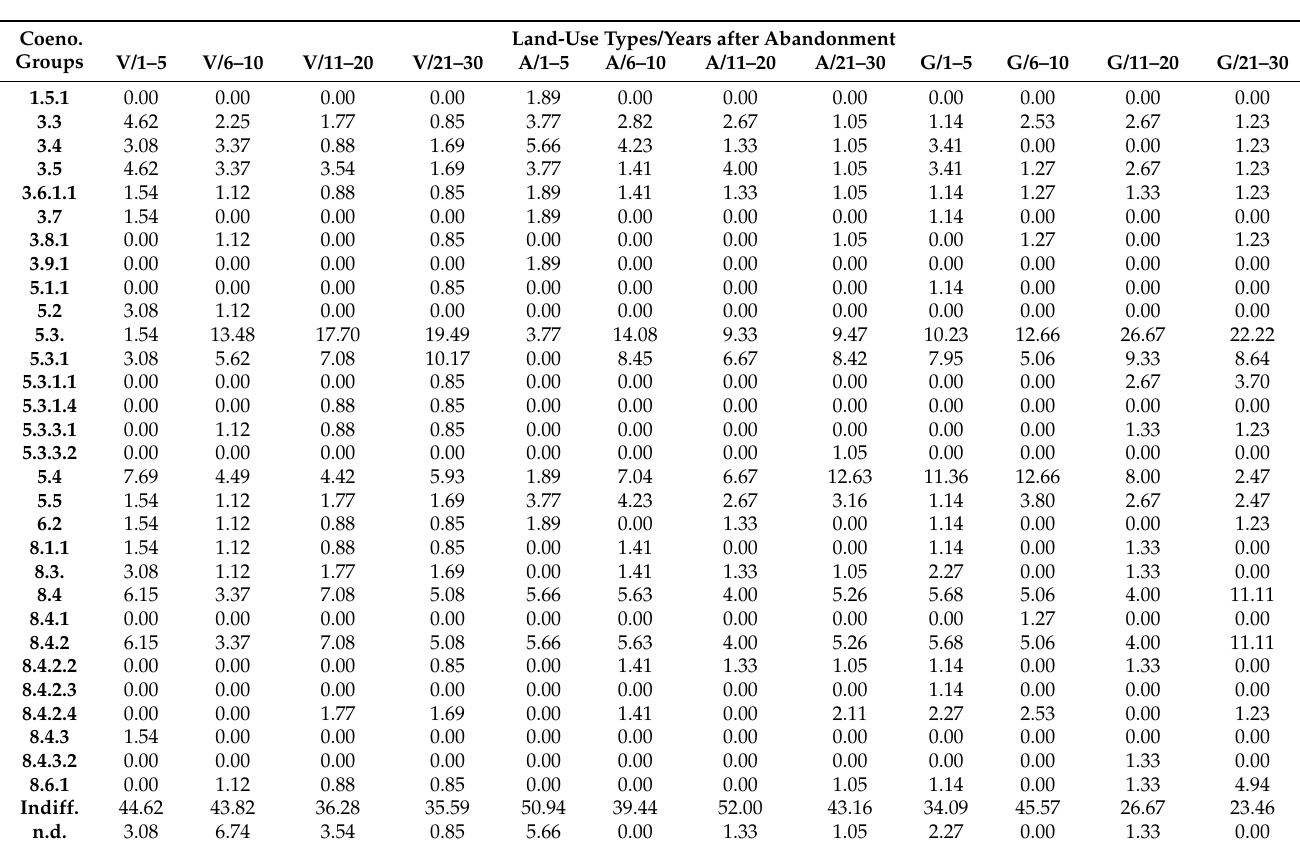
Table 2. Relative proportion of coenosystamatical groups of the species in abandoned lands (V—vineyards, A—arable land, G—grasslands, 1.5.1 Phragmitetalia , 3.3 Chenopodietea , 3.4 Secalietea , 3.5 Artemisietea